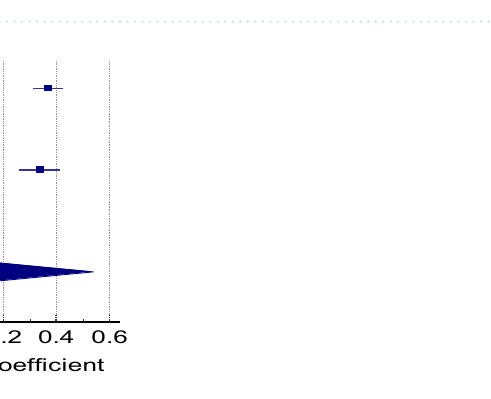
Figure 4. ( a ) Correlation between cognitive impairment and QOL ( b ) Correlation between cognitive impairment and QOL adherence.